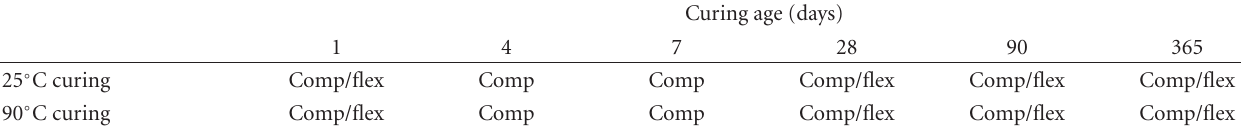
Table 4: Test schedule of mechanical properties of